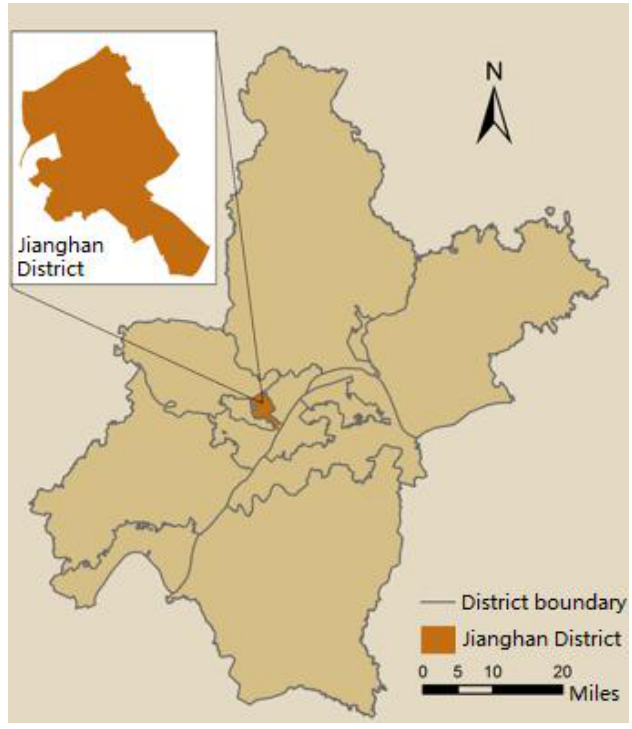
Figure 1. Jianghan District in Wuhan City.